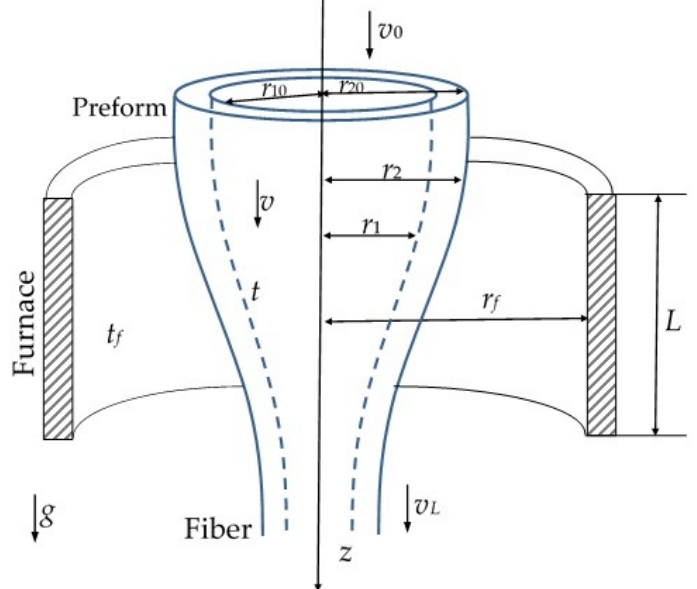
Figure 2. Configuration of the calculated area.